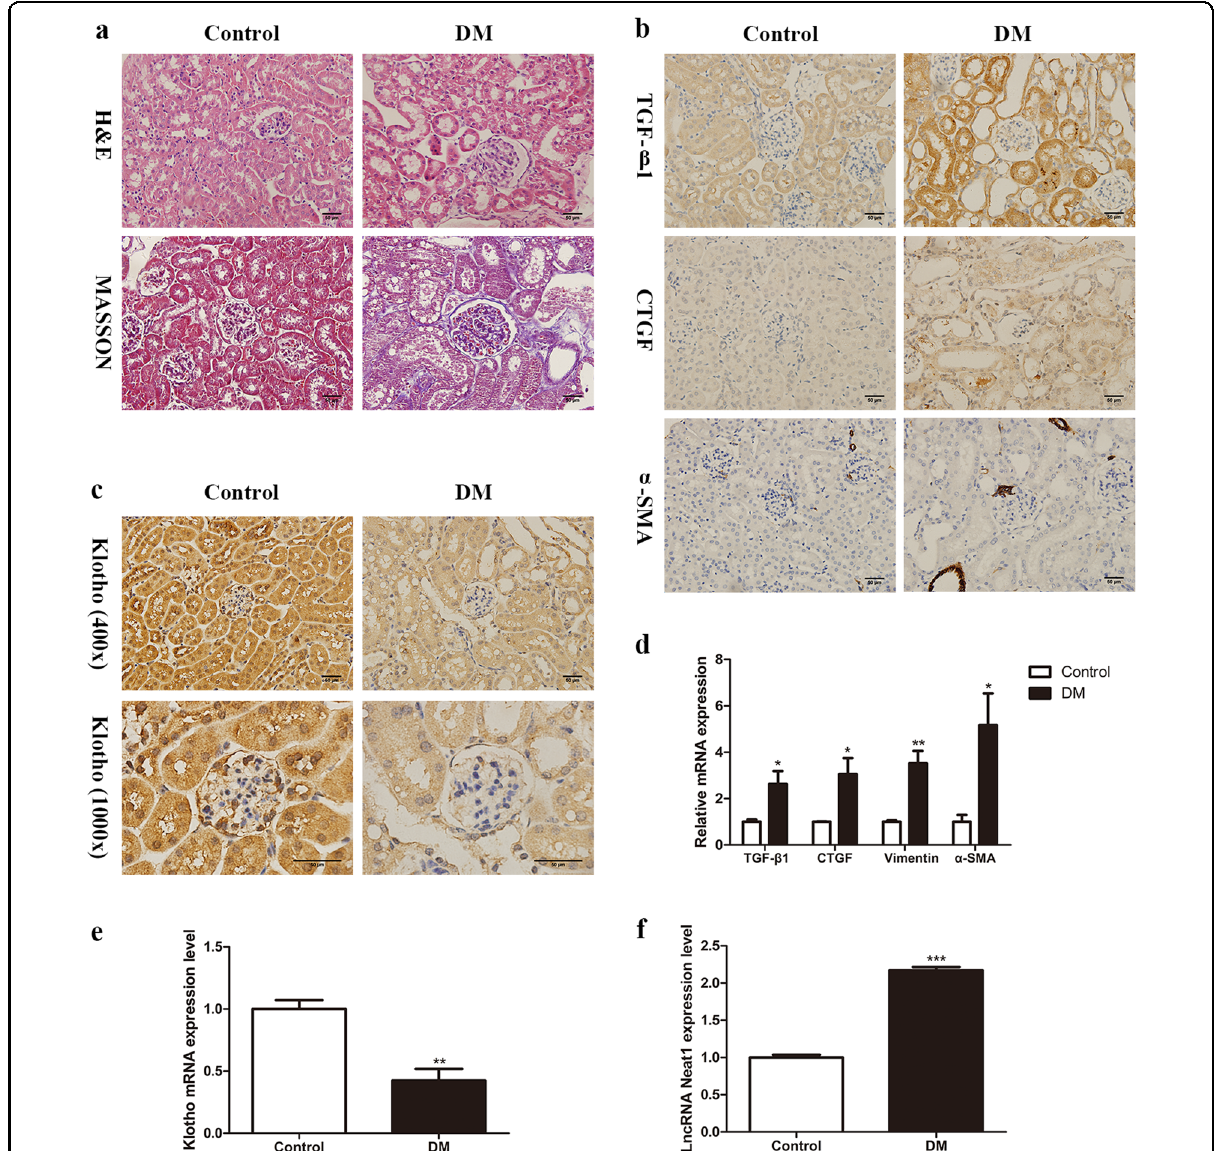
investigate whether the DM model group presented typical renal pathological changes of DKD (magni fi cation, ×400). b , d Immunohistochemistry and qRT-PCR were performed to determine the TGF- β 1, CTGF, vimentin and α -SMA expression levels in DM mice (magni fi cation, ×400). c ,